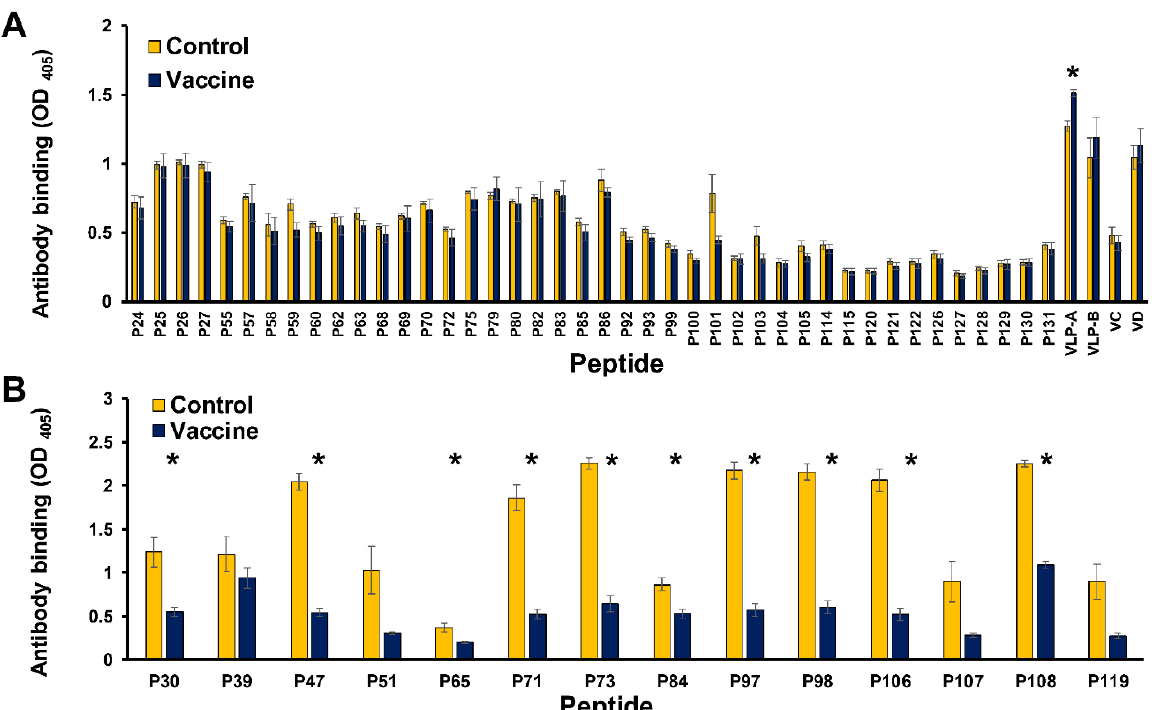
Figure 4. Screening anti-viral peptide-specific IgGs could differentiate PCV2-vaccinated pigs from non-vaccinated ones. Each group contained three samples from three individuals of different ages (18, 21, and 24 weeks of age, respectively). ( A ) 42 peptides (capsid peptides and other ORFs peptides), two VLPs (VLP-A, VLP-B), and two inactive PCV2 viruses (VC, VD) were used as coating antigens in the iELISA test. ( B ) 14 peptides (C-terminus of the capsid peptides) were used as coating antigens in the iELISA test. The data represent the mean ± standard error. Significant p values are indicated as * p < 0.05.